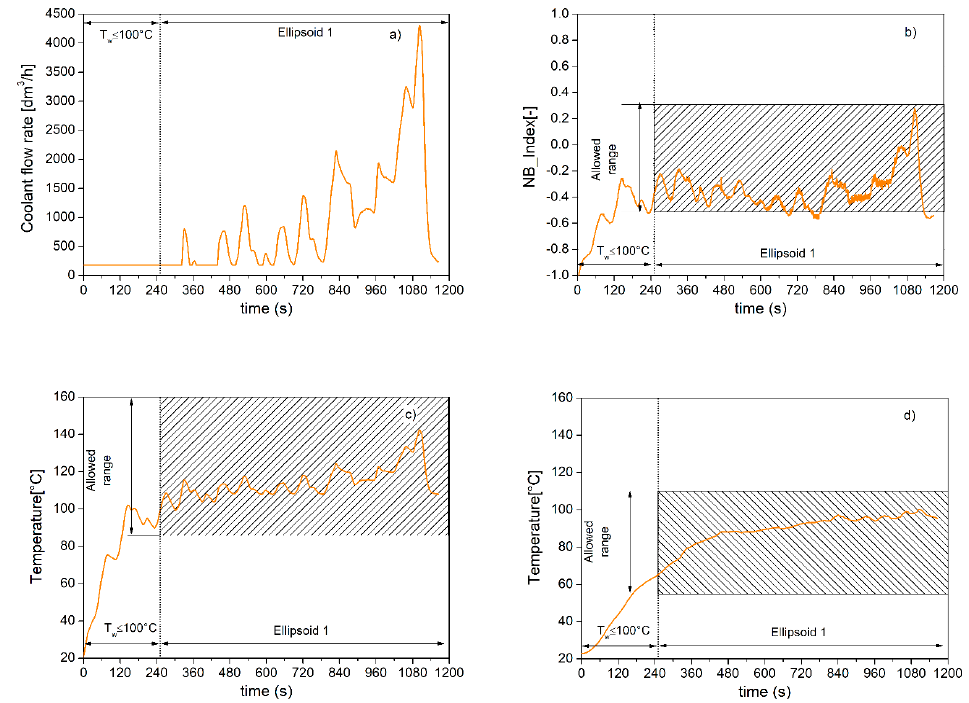
Figure 10. Coolant flow rate ( a ), NB_Index ( b ), wall ( c ), and coolant ( d ) temperature when the controller operates with low boiling levels.